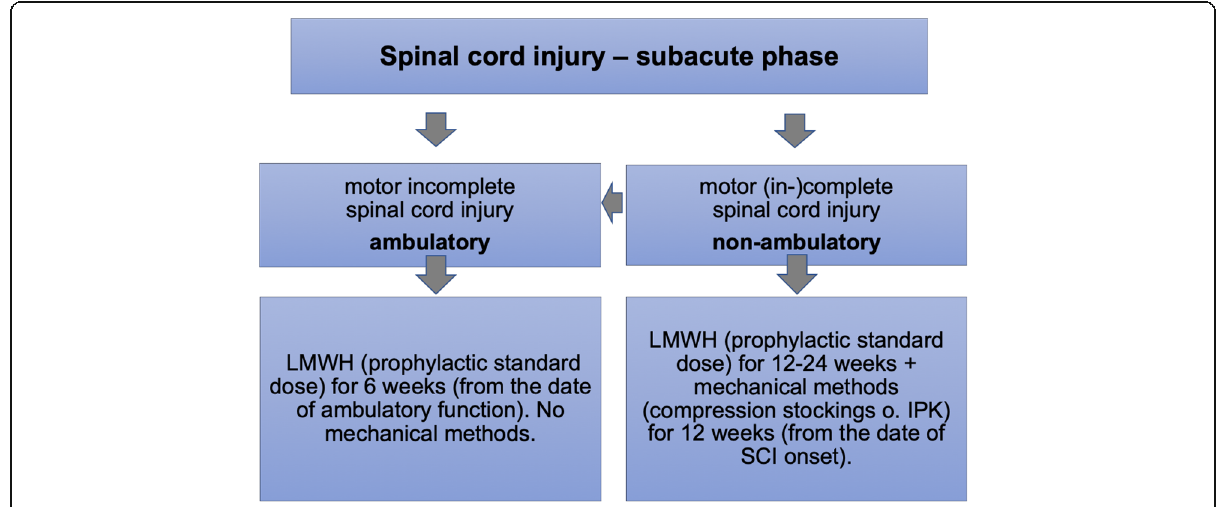
Fig. 1 Flow chart VTE prophylaxis in subacute